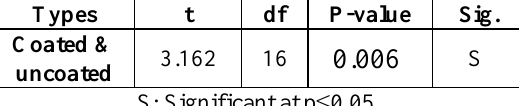
Table 3: t-test for equality of means of torque value for CaCO 3 coated and uncoated